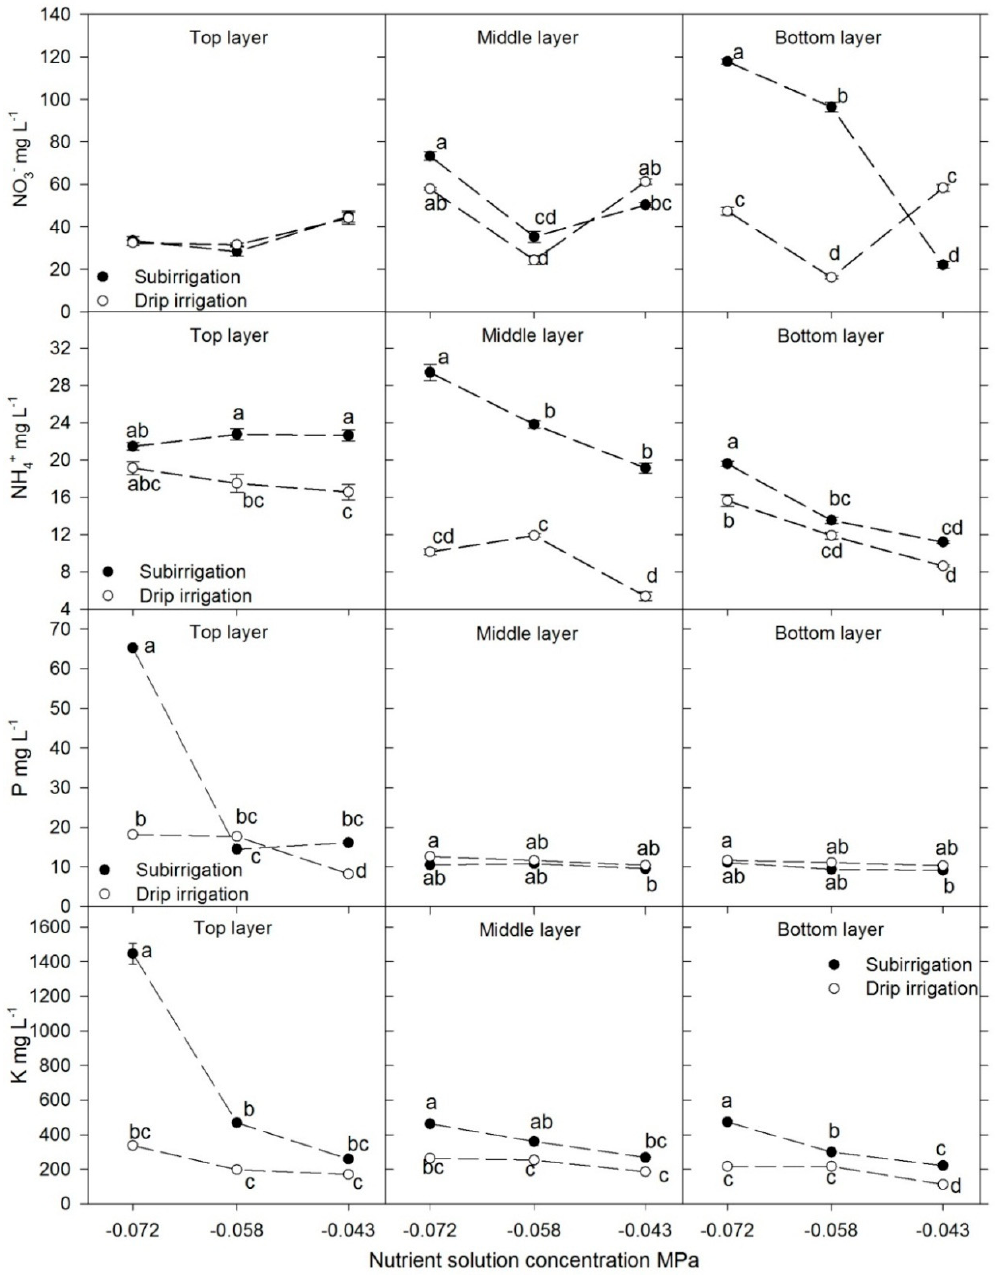
Figure 3. Nitrate (NO 3 − ), ammonium (NH 4+ ), phosphorus (P) and potassium (K) concentration in three substrate layers as affected by irrigation method (IM) and nutrient solution concentration (NSC) at the termination of the experiment in Solanum lycopersicum L. (tomato) plants. For all the nutrients, the single factors and interactions were significant at p ≤ 0.001, except for the IM × NSC interaction in substrate NH 4+ concentration ( p = 0.354). Means with the same small case indicate non-significant differences according to Tukey´s multiple comparison test. Bars represent the standard error of the mean (n = 4).